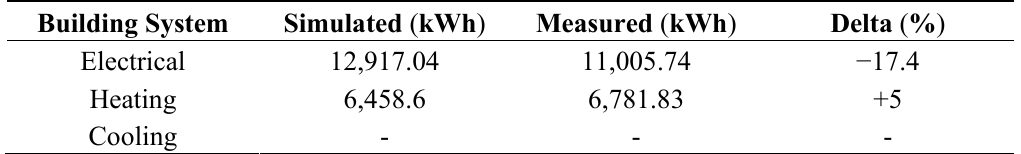
Table 1. Simulation and measured comparison